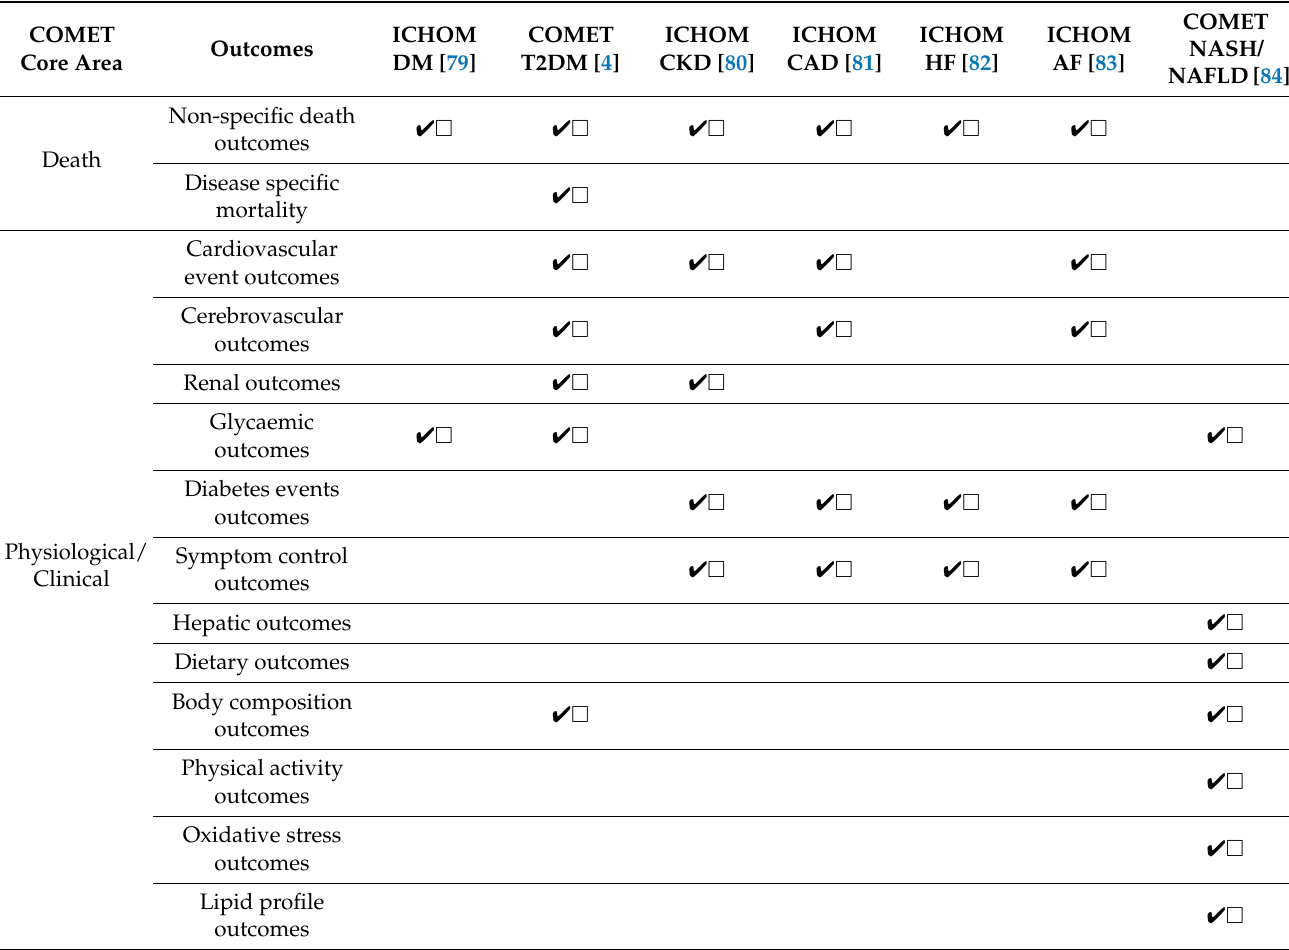
Figure 4. Frequency of outcomes requested by COS, grouped by COMET taxonomy core areas. Table 3. Comparison of core areas and outcome domains requested by